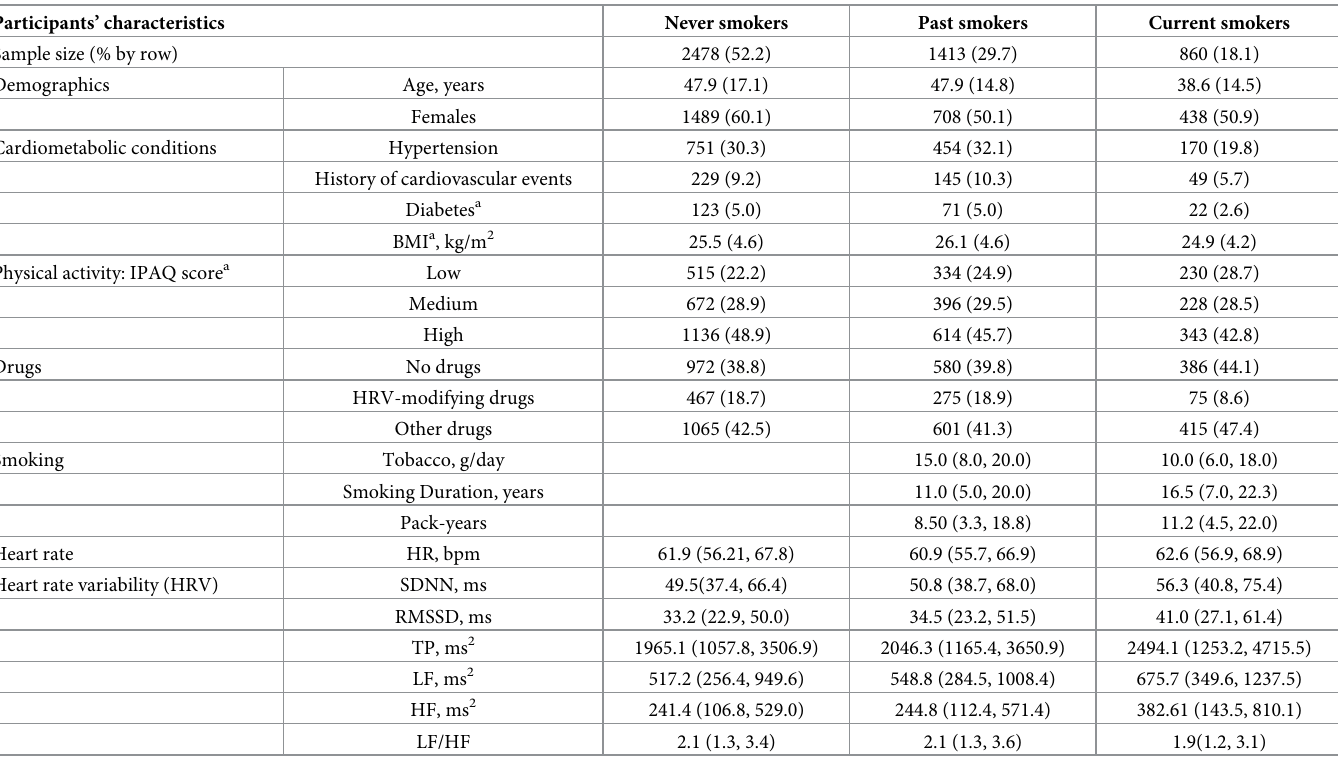
Table 1. Characteristics of the study participants according to smoking status �